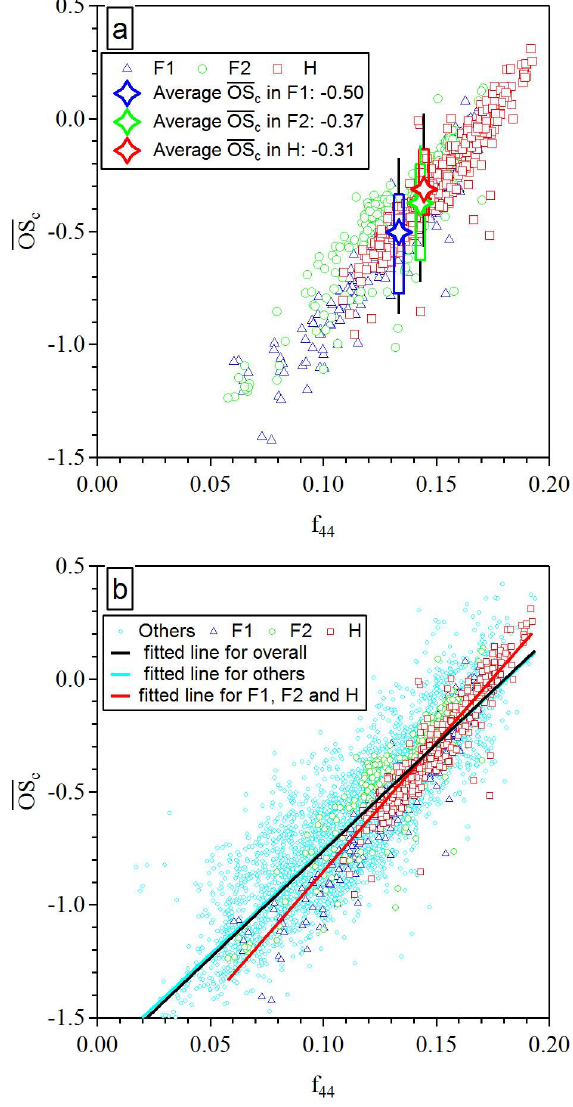
Fig. 4. (a) Carbon oxidation state (OS c ) vs. m/z 44 fraction in or- ganic mass spectra ( f 44 ) in F1 (blue triangle), F2 (green circle), and H (red square) periods. The blue, green, and red stars show the average values of OS c and f 44 in F1, F2, and H, respectively. The boxes and whiskers show the 25th/75th and 10th/90th percentiles of the values of OS c in each period, respectively. (b) Fitted lines of the OS c vs. f 44 data for all data (black line), for all three chosen periods (F1, F2, and H) (red line), and for the “other” period (light blue line). See Table 2 for fitted